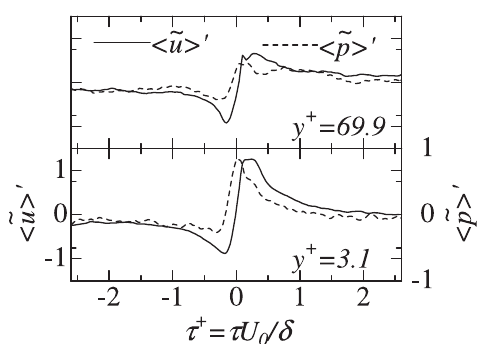
Fig. 8 Ensemble-averaged time histories of conditionally sampled velocity and wall static pressure. The detection is based on the VITA technique